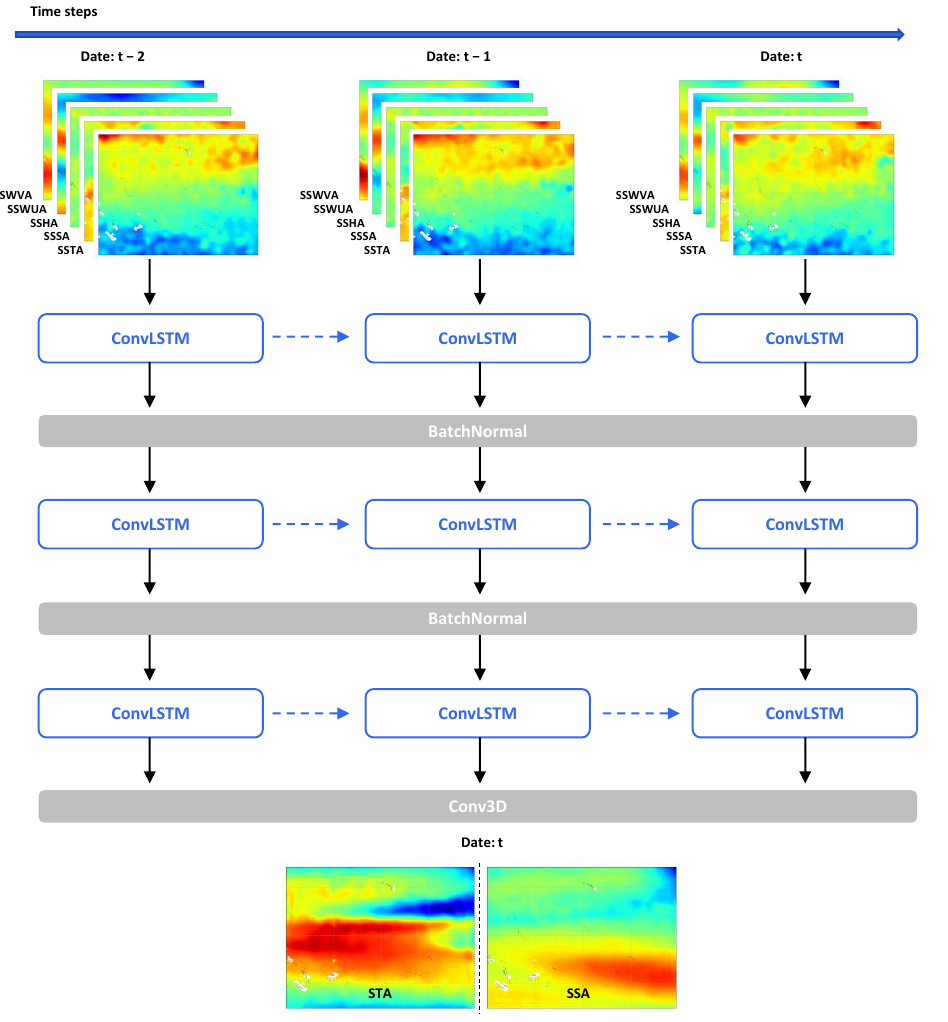
Figure 2. Flowchart for STA/SSA inversion in the Pacific Ocean using remote sensing data based on the ConvLSTM